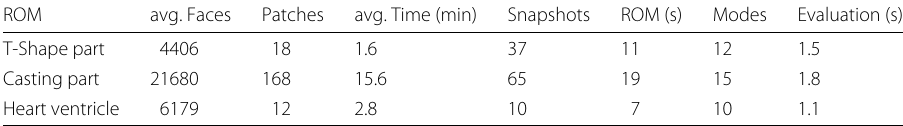
Table 3 Run times and statistics: average number of faces in the input triangulated meshes, patches in the quadrilateral layout, average computation time per snapshot, number of snapshots in the reduced order model, reduced order model building time, number of modes and evaluation time of the geometry ROM avg. Faces Patches avg. Time (min) Snapshots ROM (s) Modes Evaluation (s) T-Shape